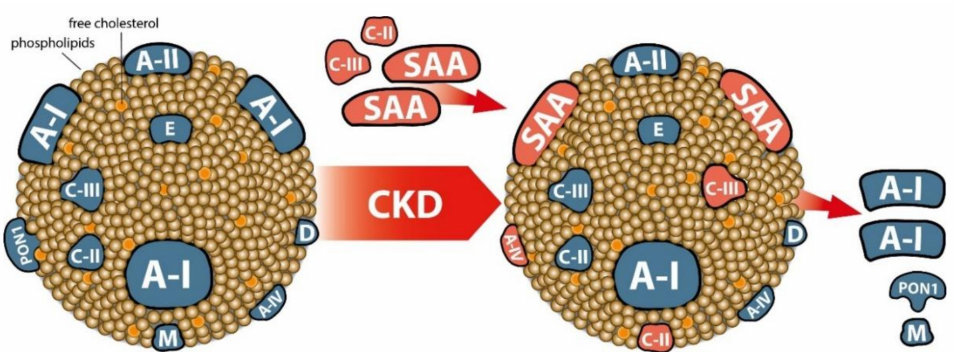
Figure 2. Most frequently identified changes in the proteome of HDL in CKD patients. Approximately 70% of the HDL protein mass is comprised of apoA-I (A-I), while apoA-II(A-II) comprises about 15–20% [50]. The remaining 10–15% of protein mass is composed of less abundant proteins, including apoC-III, apoC-II, apoE, apoD, apoM, apoA-IV, as well as enzymes such as paraoxonase 1 (PON1) and lipid transfer proteins, including lecithin:cholesterol acyl transferase and cholesteryl ester transfer protein [50]. To simplify the illustration only the major constituents of HDL are shown. In CKD, a specific remodeling of the HDL particle occurs depending on the stage of CKD and the vintage of dialysis treatment. The most noticeable change in the composition of HDL in CKD is the accumulation of serum amyloid a (SAA), especially SAA1, together with the enrichment in apoC-II and apoC-III. The accumulation of these proteins is accompanied by a loss of apoA-I, apoA-II, apoM and a decrease in the mass and enzymatic activity of paraoxonase 1